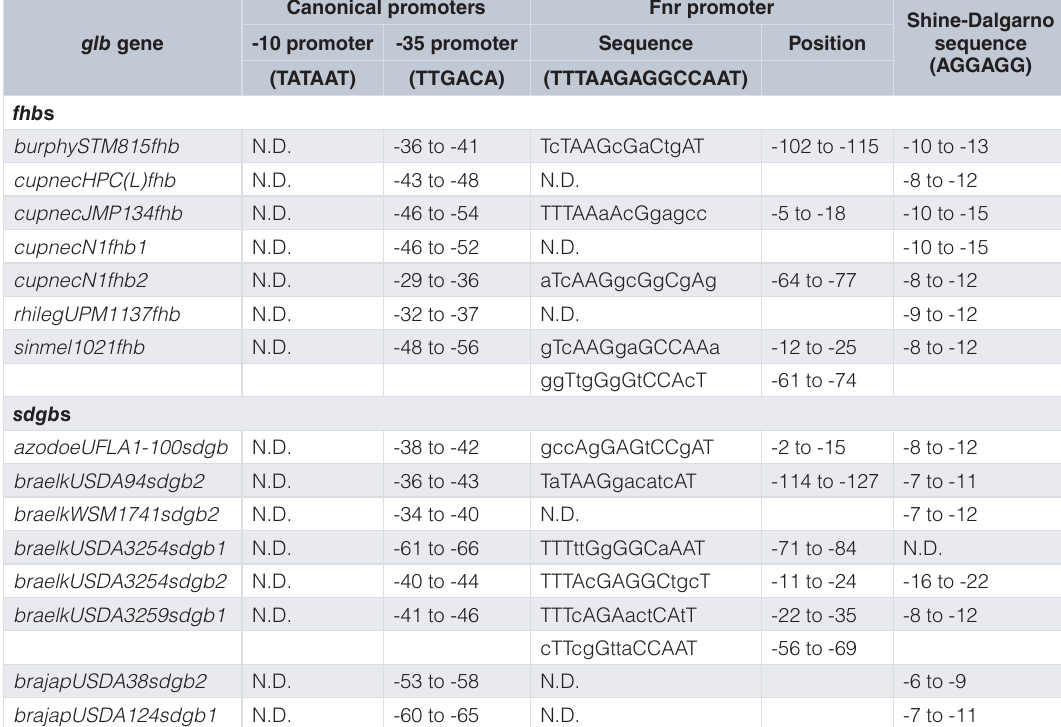
Table 2. Position of canonical and Fnr-like promoter sequences and Shine-Dalgarno sequence within 130 nucleotides upstream to selected rhizobial glb genes. Consensus sequences are indicated in parenthesis. Identical and non-identical nucleotides into the Fnr-like promoter sequences to the consensus Fnr promoter sequence are indicated with upper- and lowercase letters, respectively. N.D., non-detected.